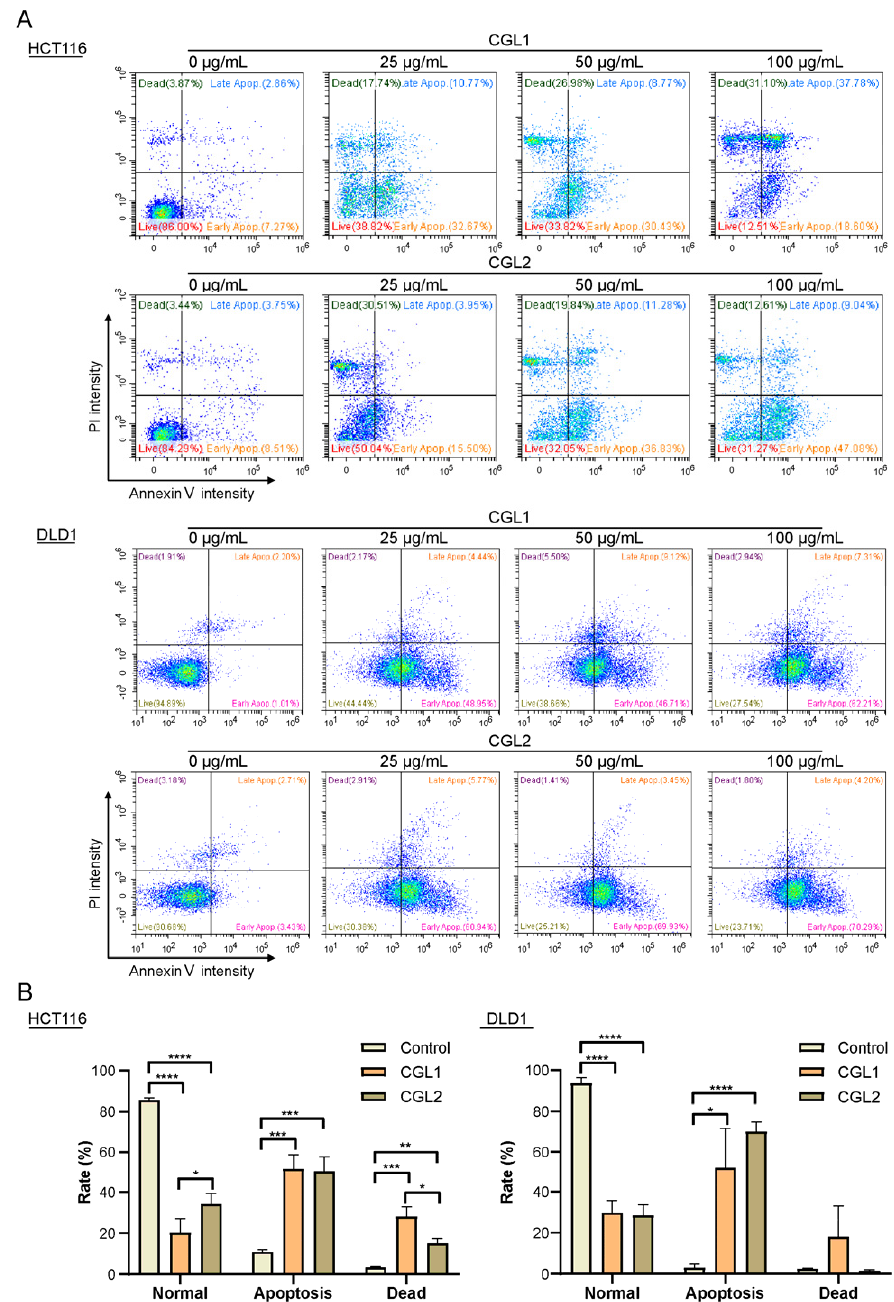
Figure 4. CGL1 and CGL2 induce HCT116 and DLD1 cells apoptosis. HCT116 (( A ), the upper panel) and DLD1 (( A ), the lower panel ) cells were incubated with serials concentrations of CGL1 and CGL2 for 16 h, dually labeled with Annexin and PI, and then analyzed using flow cytometry. The ratios of normal, apoptosis, and dead HCT116 (( B ), the left panel ) and DLD1 (( B ), the right panel ) cells after being treated with 100 µ g/mL CGL1 or CGL2 for 16 h were analyzed using a student’s t -test (* p < 0.05, ** p < 0.01, *** p < 0.001, **** p < 0.0001). Data show mean ± SD, n = 3. The classic apoptotic markers were detected by western blotting to unveil the mech- anism by which CGL1 and CGL2 induced cell apoptosis. As shown in Figure 5, the expression of anti-apoptotic protein BCL-XL in HCT116 and DLD1 cells decreased after CGL1 and CGL2 treatment, with CGL1 exhibiting a more significant reduction than CGL2 in DLD1 cells ( p < 0.001). Correspondingly, the downstream proteins Caspase-3,